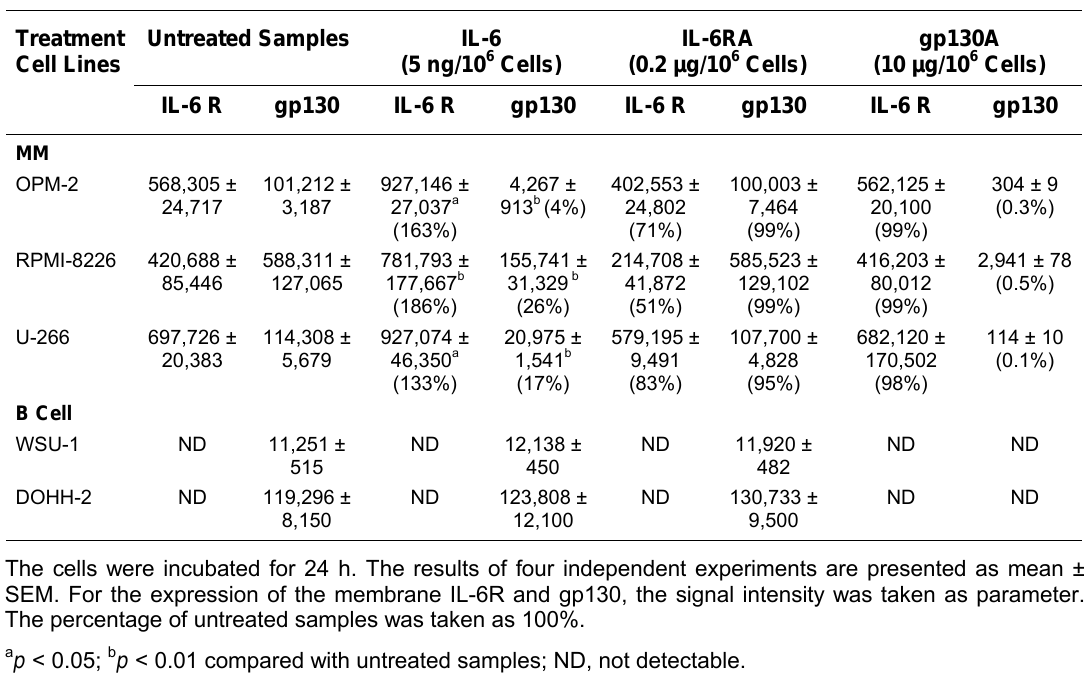
The Effects of IL-6, IL-6RA, and gp130A on the Expression of the Surface IL-6R and Membrane Protein gp130 in Human MM and B Cell Lymphoma Cell Lines Untreated Samples